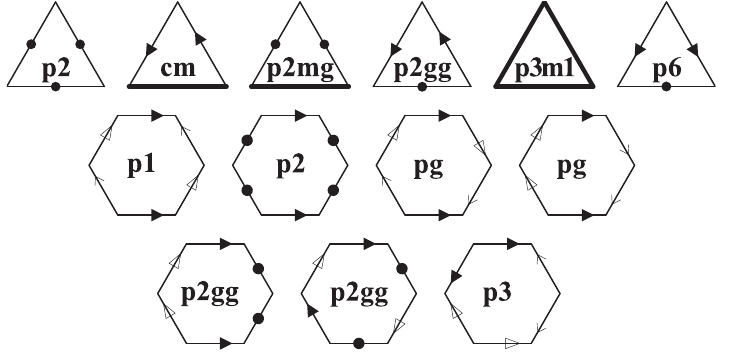
Figure 5. Edge identifications of the regular triangle and the regular hexagon generating Euclidean crystallographic groups.